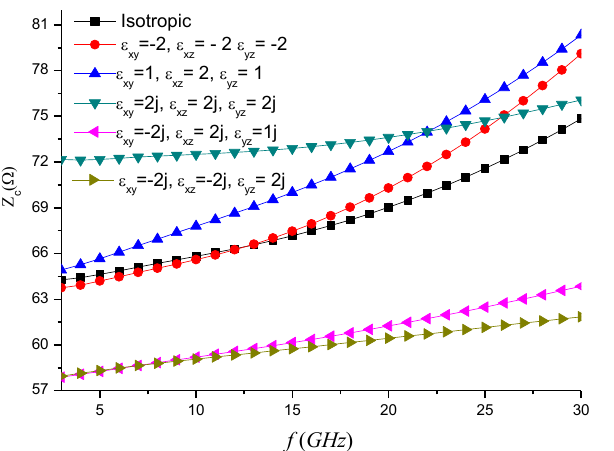
Figure 11: Effect of the gyrotropic anisotropy on the characteristic